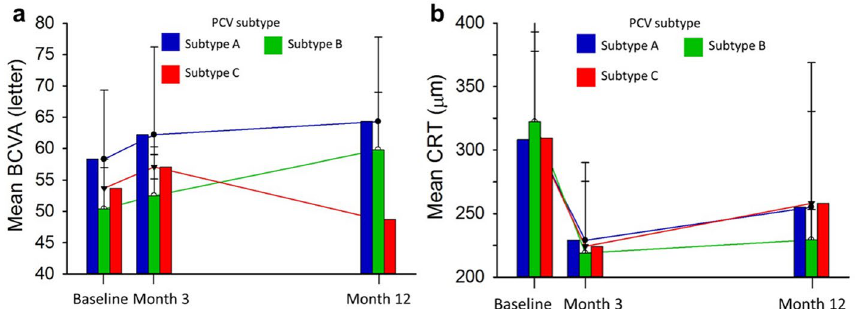
Figure 2. Visual outcomes by PCV subtype during the 12-month treatment. ( a ) Mean BCVA. ( b ) Mean CRT. Blue line, PCV subtype A; green line, PCV subtype B; red line, PCV subtype C. BCVA best-corrected visual acuity, BVN branching vascular network, CRT central retina thickness.